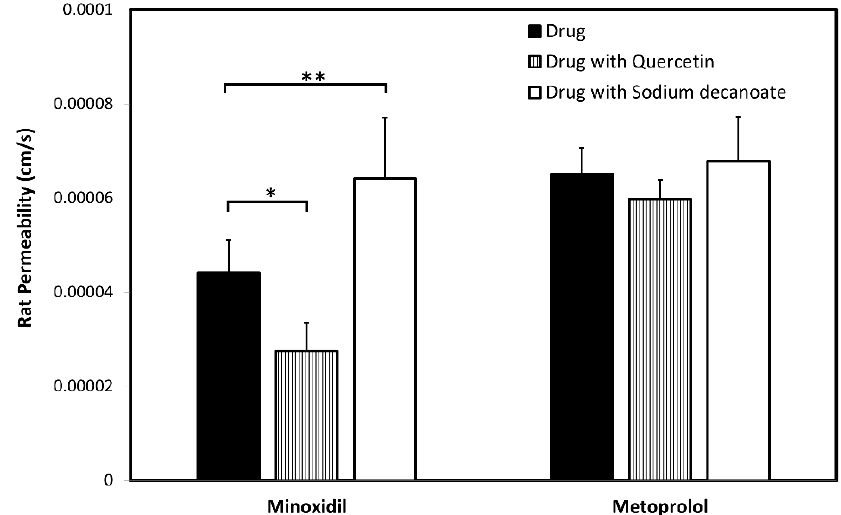
Table 3. Comparison of the selected input values and literature data for minoxidil pharmacokinetic parameters.